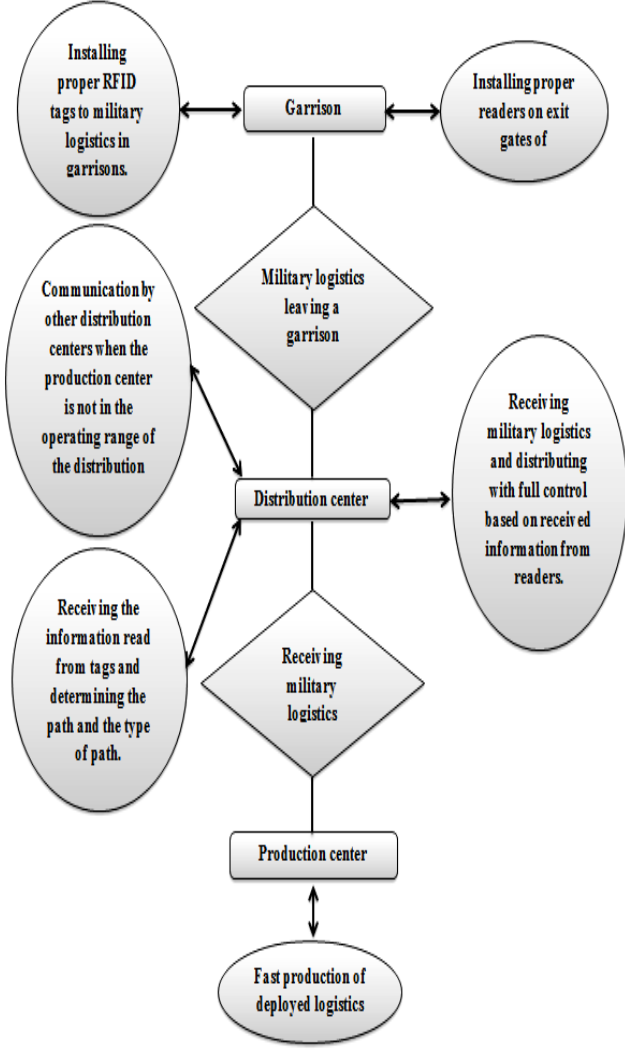
Figure 3. Cycle of military logistics via